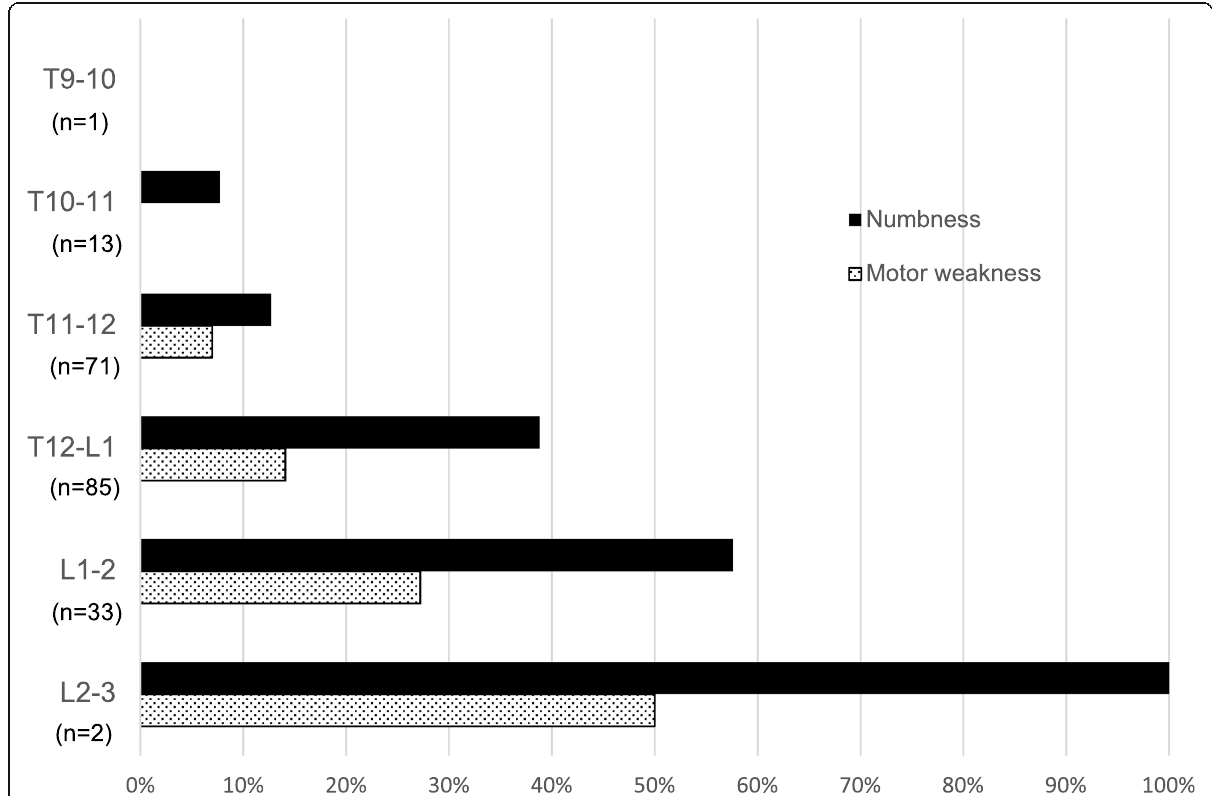
Fig. 1 The incidence of lower extremities numbness and motor weakness with respect to epidural catheter placement site examined by